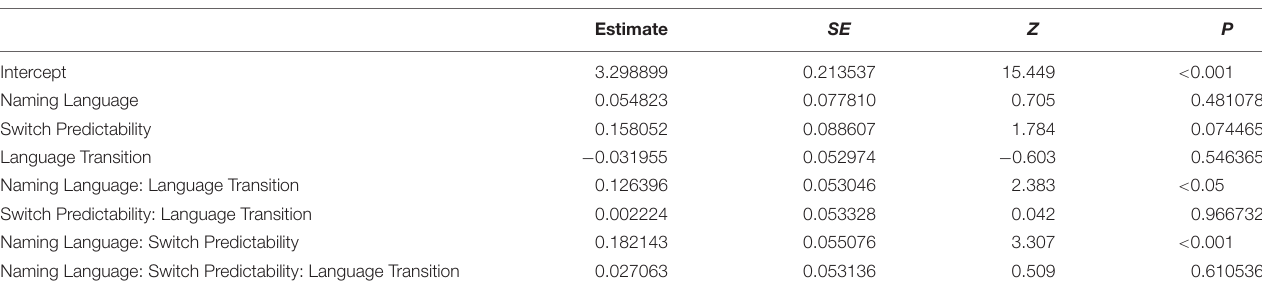
TABLE 2 | Results of LME on ACC.